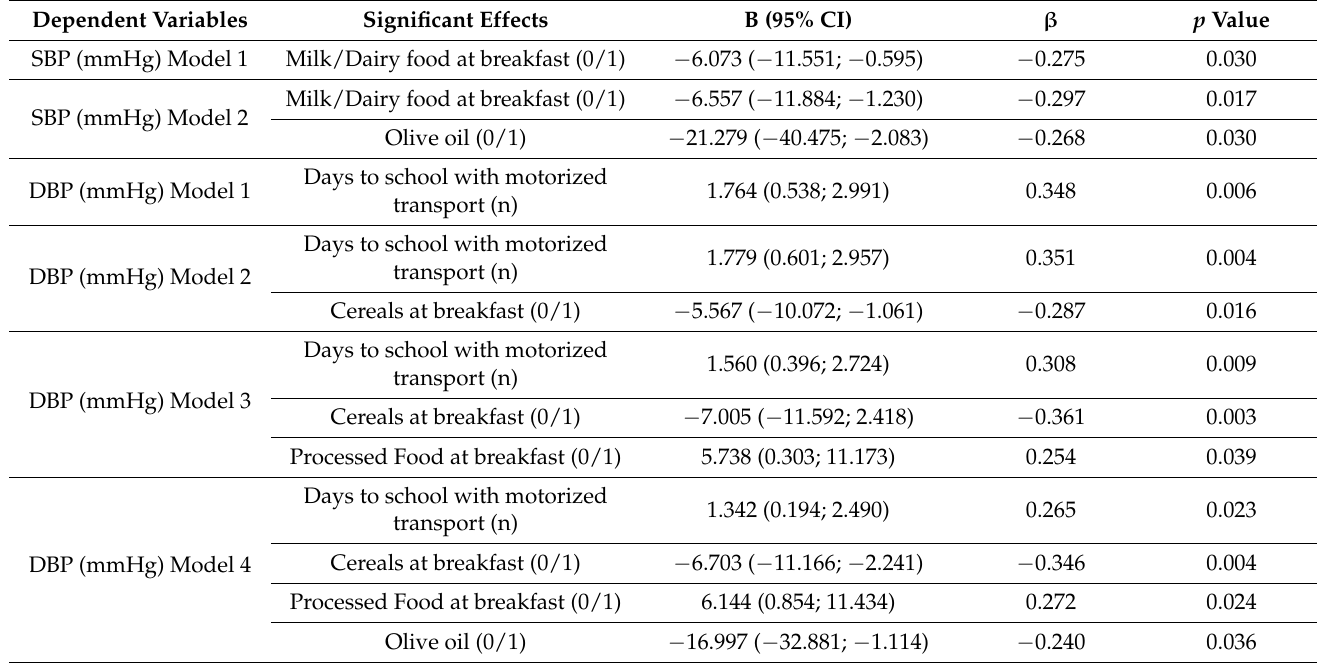
Table 6. Multiple stepwise regression analysis results of significant effects (independent variables) on blood pressure (dependent